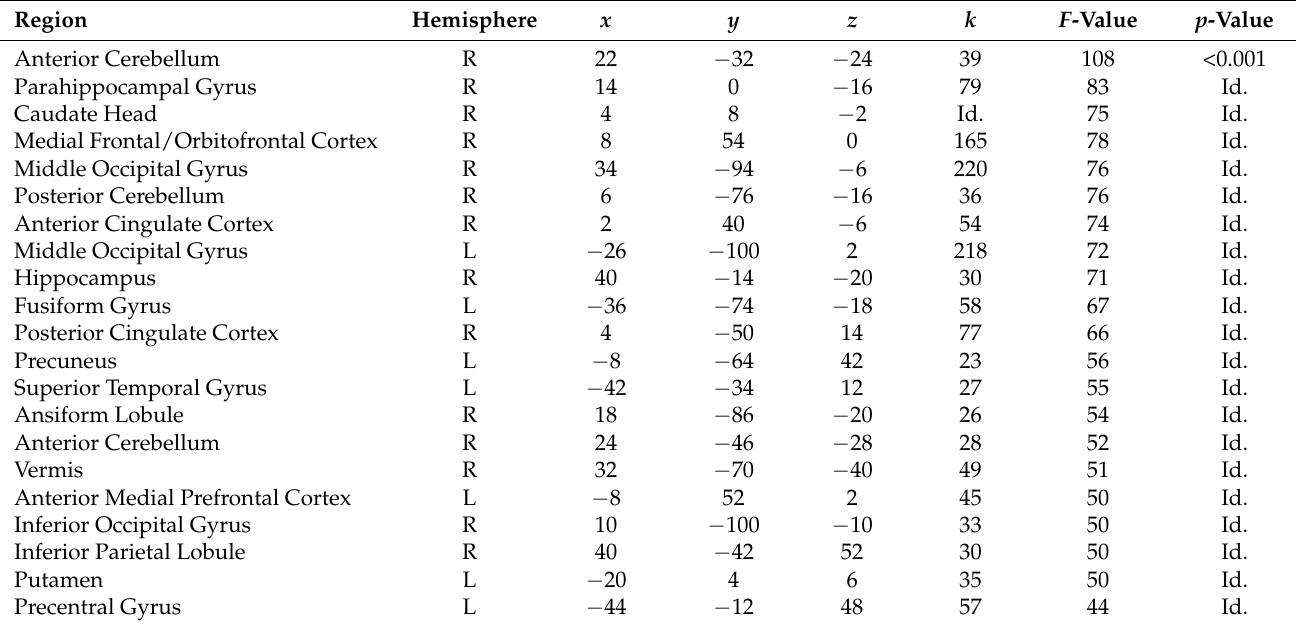
Table 2. Glycemia-dependent functional connectivity of the